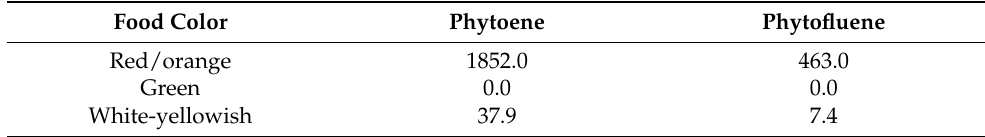
Table 3. Contribution of foods (fruit, vegetables, sauces, and beverages) grouped according to the color of their edible part to the daily intake ( µ g/person/d). Food Color Phytoene Phytofluene Red/orange 1852.0